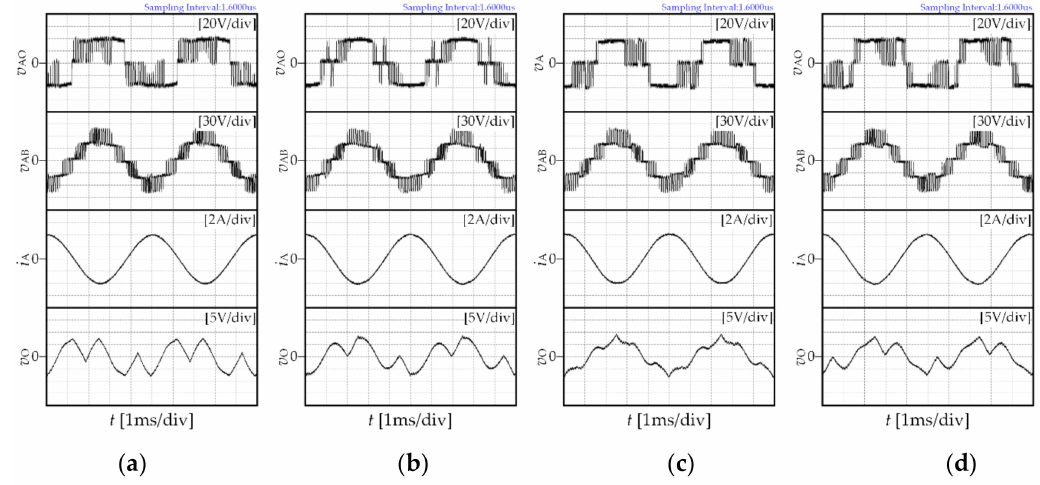
Figure 10. Experimental results of IDPWM0–IDPWM3 under two-phase load conditions when m ’ = 0.8: ( a ) IDPWM0; ( b ) IDPWM1; ( c ) IDPWM2 ( d )